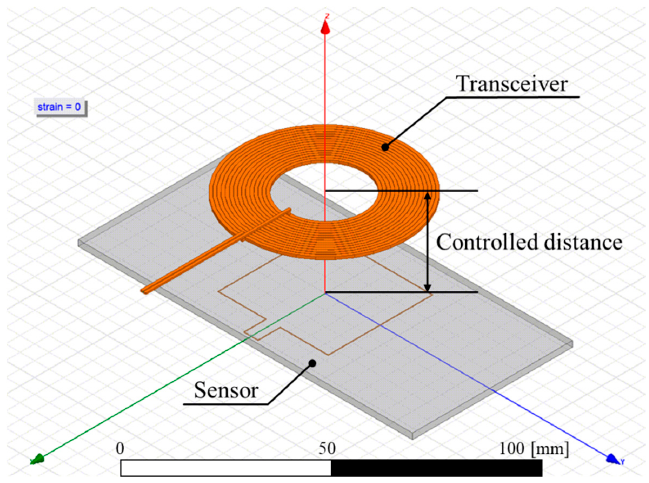
Figure 5. Simulation model of the sensor and the transceiver for wireless sensing. The distance between the sensor and the transceiver was changed from 10 mm to 50 mm, and the strain applied to the sensor was changed from 0% to 100%. In this figure, the transceiver is 20 mm away from the non ‐ stretched sensor.